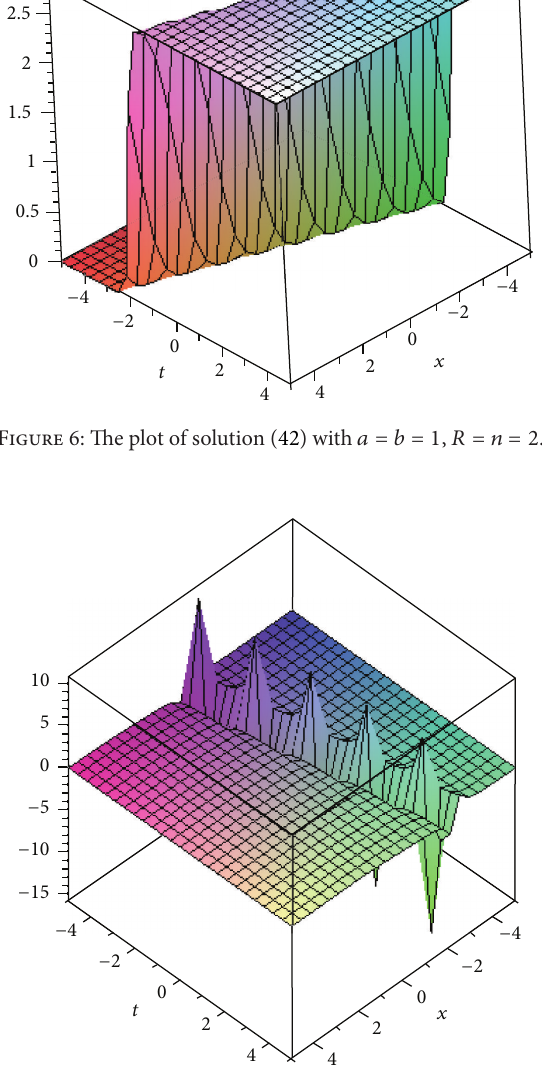
Figure 7: The plot of solution (51) with 𝑝 = 1 , 𝐴 = 𝑅 = 2 , 𝐵 = 𝜇 = 3 , and 𝑘 = 0